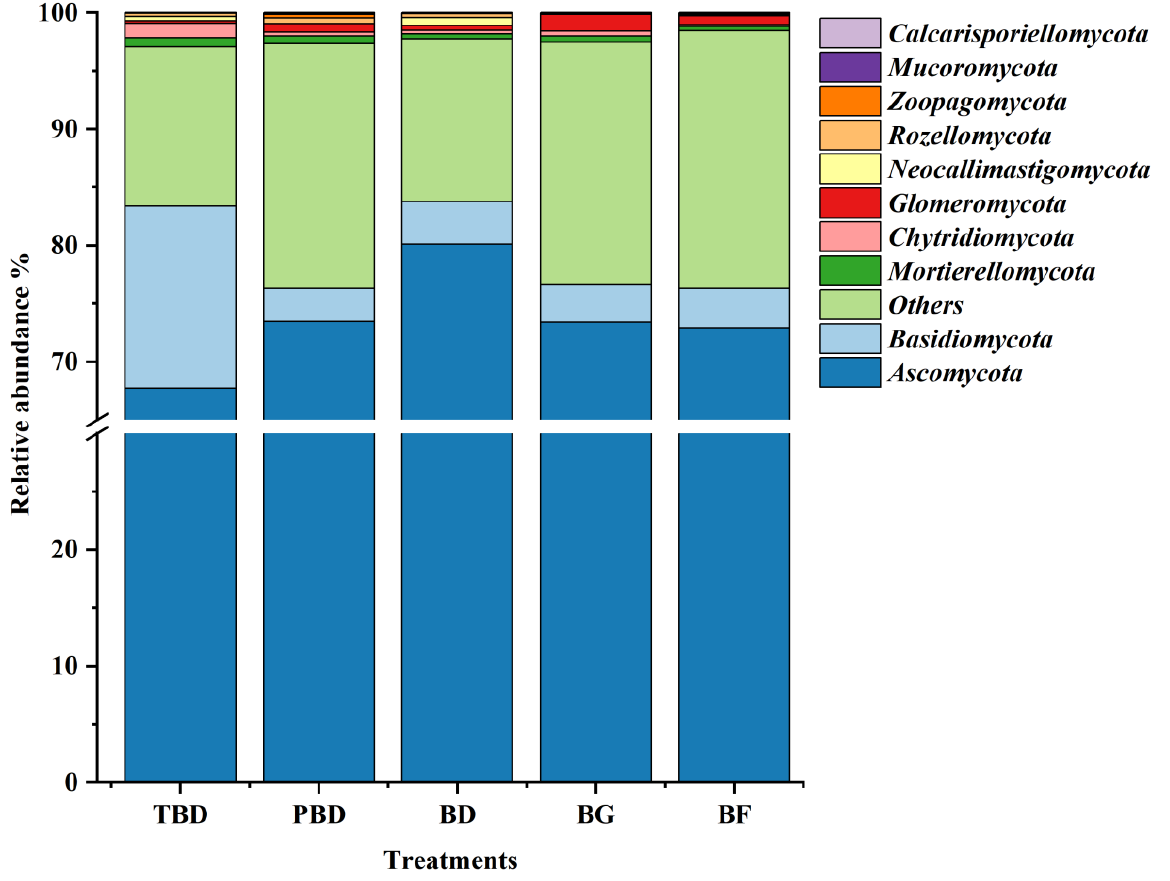
Figure 2. Distributions of fungi in different treatments (phylum level). BD, biochar–organic